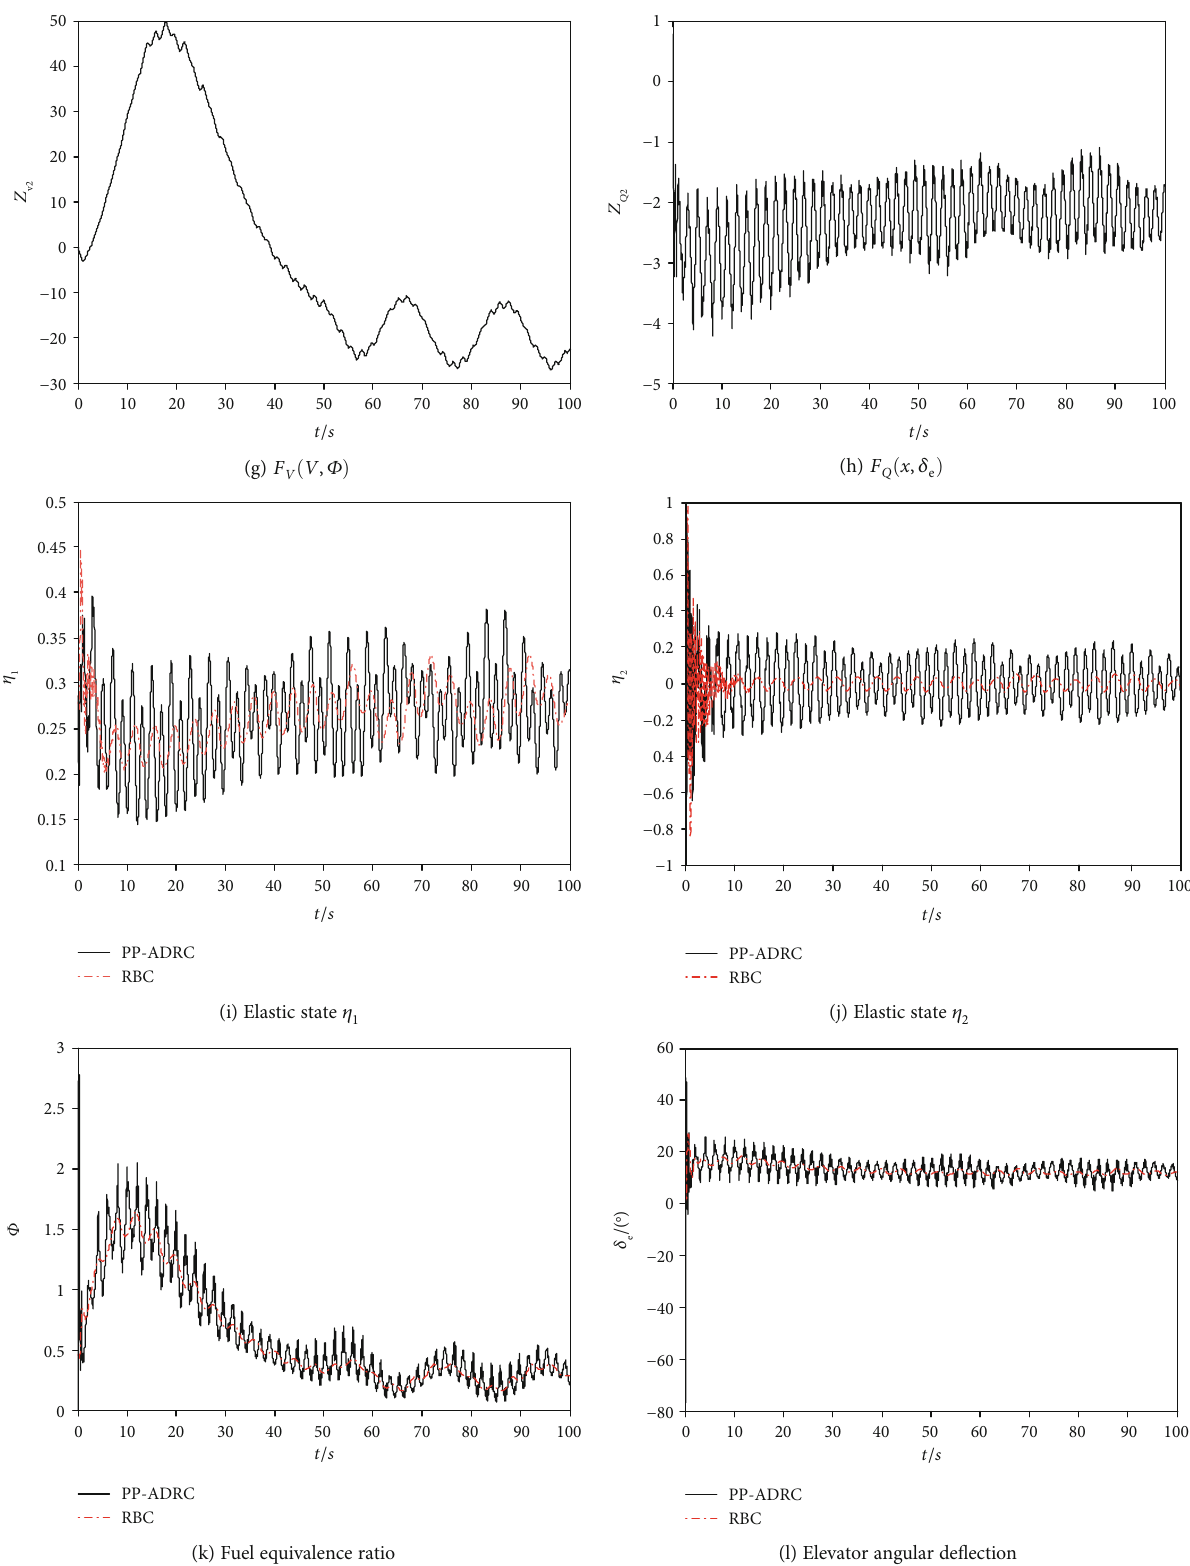
Figure 3: Simulation results for Scenario